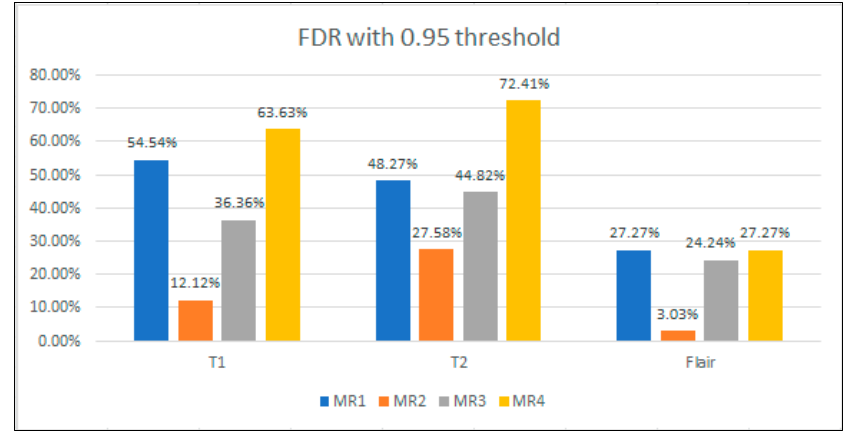
Figure 11. FDR of MRs on T1, T2 and flair-type images.